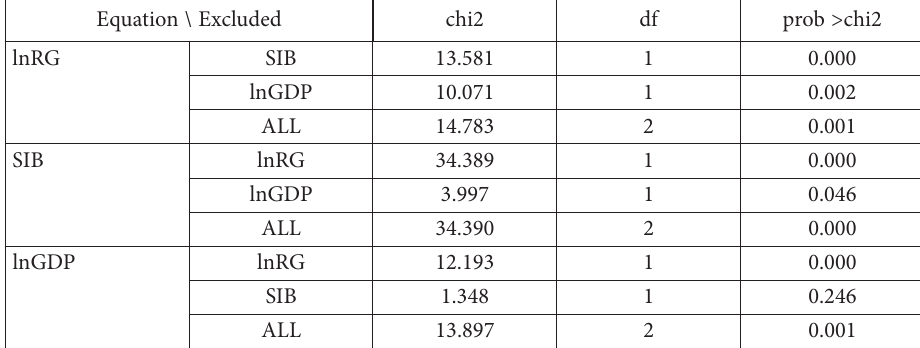
Table 8. Panel VAR-Granger causality Wald test (source: author’s calculation using STATA pro- gramme,